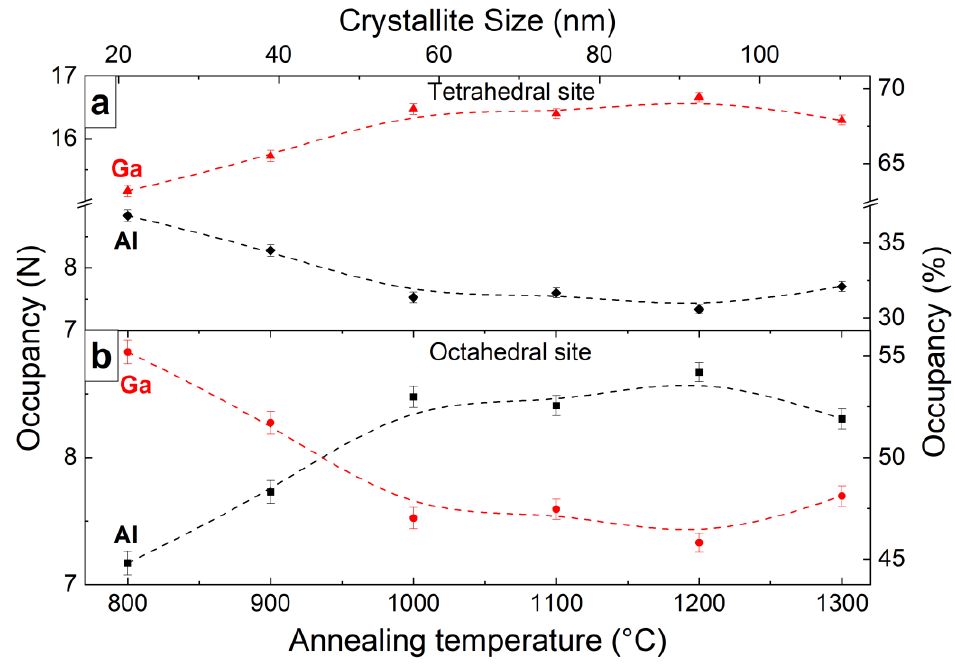
Figure 3. The influence of the annealing temperature on the occupancy of the tetrahedral ( a ) octahedral ( b ) sites of the Y 3 Al 2 Ga 3 O 12 nanopowders.